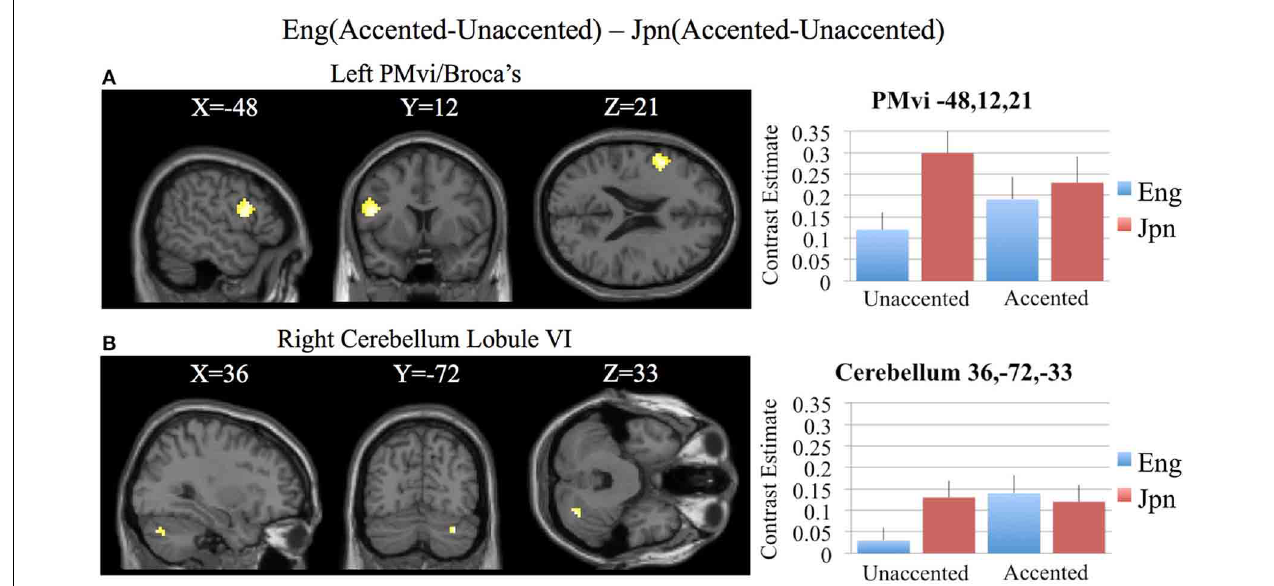
FIGURE 4 | Region of interest (ROI) analysis for the contrast of Eng(accented-unaccented) – Jpn(accented-unaccented) using small volume correction ( p < 0 . 05) for multiple comparisons. (A) left PMvi/Broca’s area. (B) Right Cerebellum Lobule VI. MNI X, Y, Z coordinates